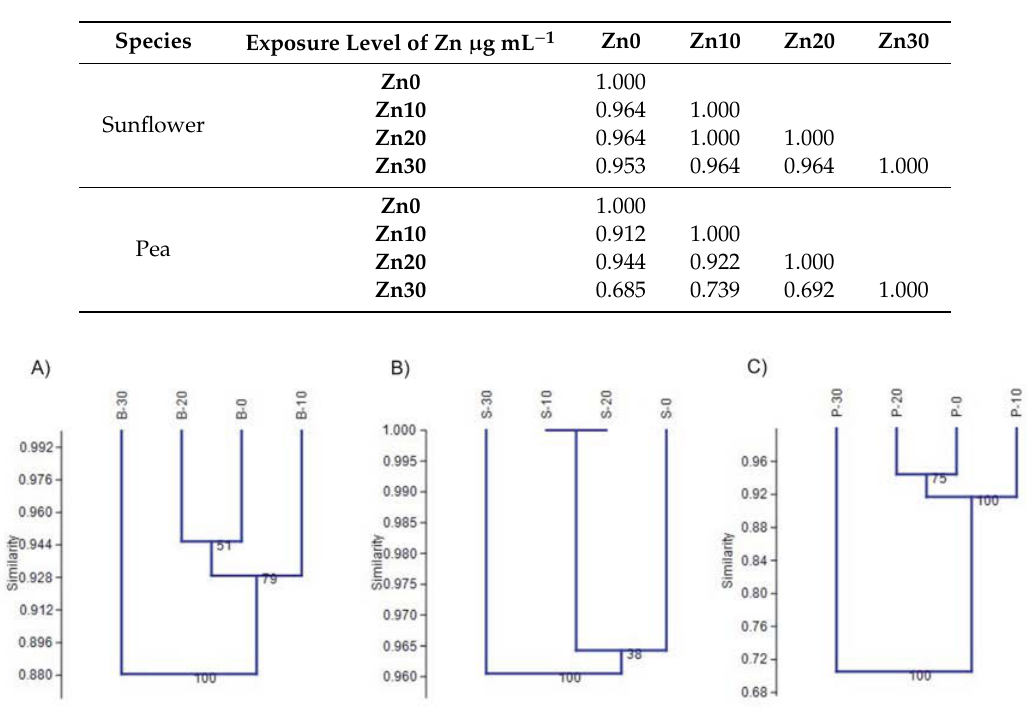
Table 4. Similarity matrix of broccoli, sunflower and pea samples generated on the basis of RAPD analysis using Jaccard similarity coefficie nt. Sprouts of all species were obtained via enrichment of seeds with Zn0, Zn10, Zn20 and Zn30.